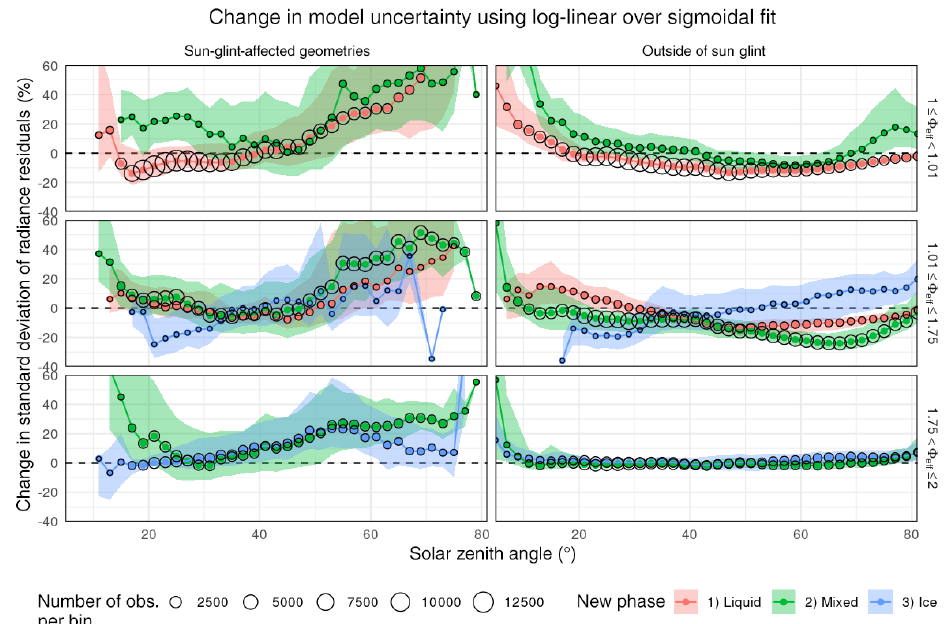
Figure 4. Using all observed angular bins within θ 0 ∈ [ 6 ◦ , 82 ◦ ] , we show how radiance residuals from proposed log-linear models compare against state-of-the-art sigmoidal fits. Results are presented by the CERES-defined cloud phase (vertically), by the newly defined phase (colors), and by whether the angular geometry is affected by sun glint (left) or free of sun glint (right). We show relative change in model uncertainty: δ = [ σ((cid:49)I LogLinear ) − σ((cid:49)I Sigmoidal ) ] /σ((cid:49)I Sigmoidal ) · 100%. Consequently, negative values relate to a better performance of the log-linear model, while positive values mark a better performance by the state-of-the-art methodology. Solid lines and dots mark the 50th percentile and shades show the interquartile range between the 25th and 75th percentiles. Point size relates to the average number of observations per angular bin. The dashed black line marks zero